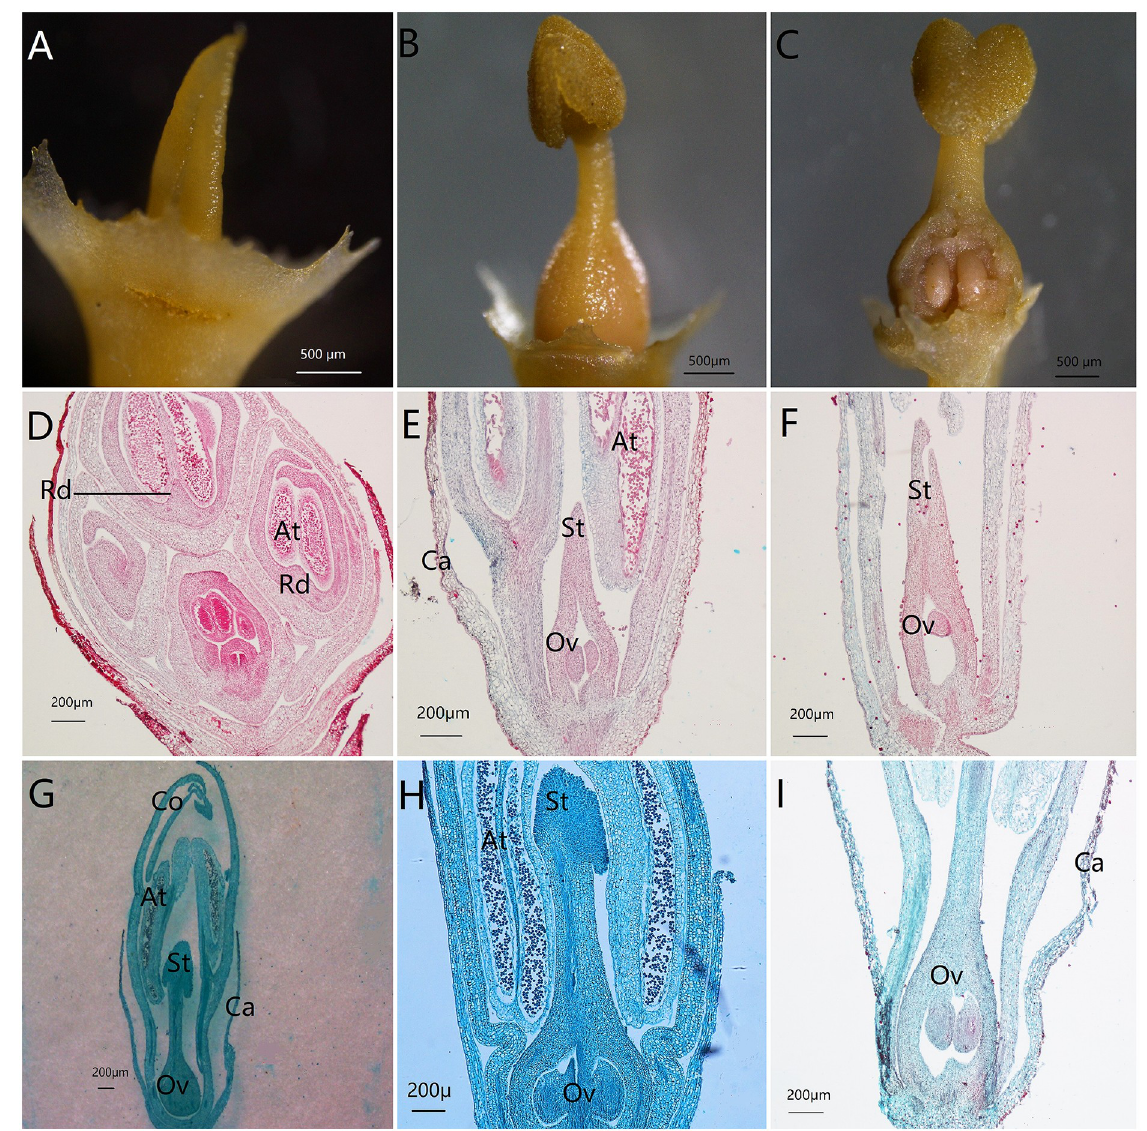
Fig 2. SEM micrographs of two sexual pistils and paraffin section micrographs of floral dimorphism in O . delavayi . Note: (A, D-F) Male. (B, C, G-I) Hermaphrodite. (A-C) Pistils of the two sexual morphs. (D-I) Longitudinal section of reproductive organs. Abbreviations: